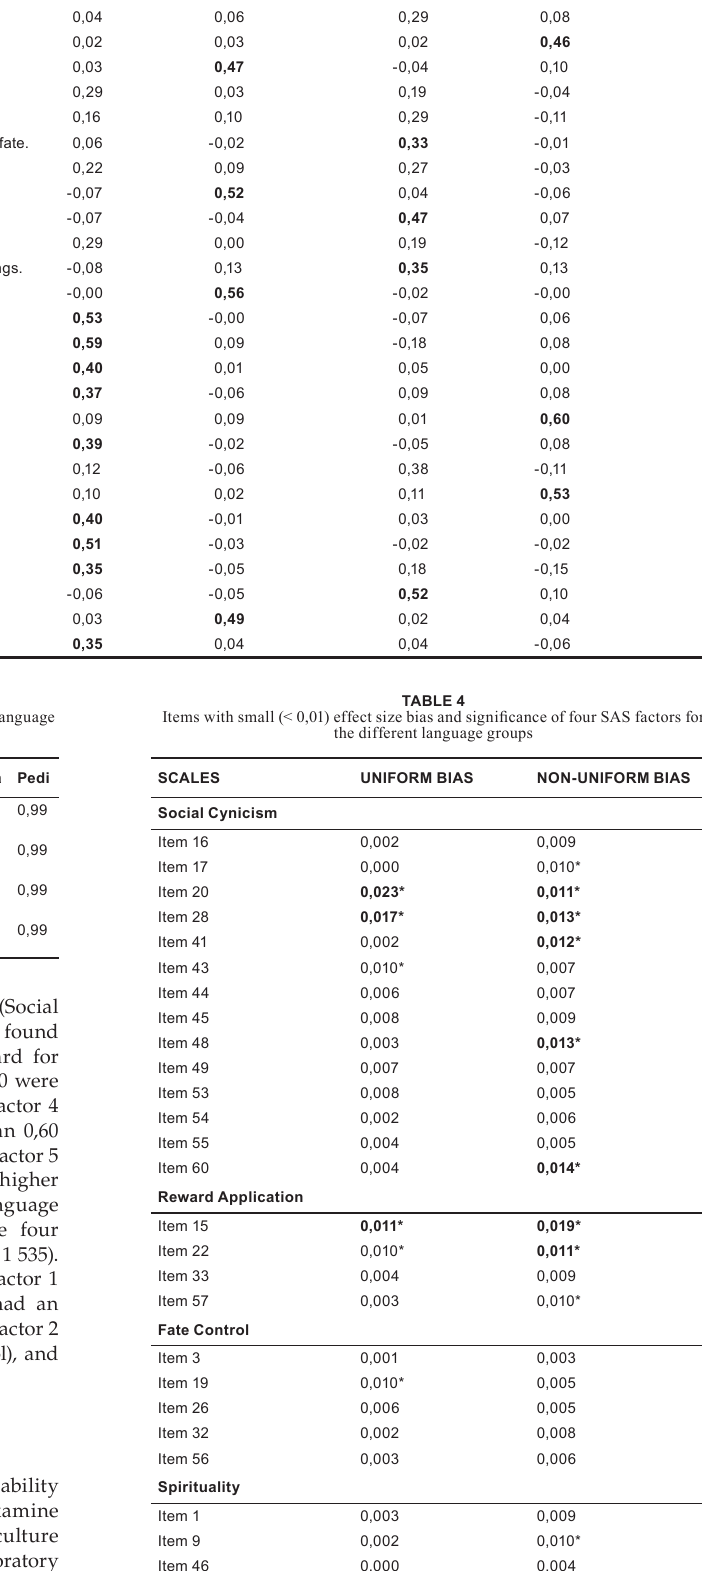
tABLe 2 Confirmatory factor analysis on the SAS items (loadings > 0,30) FActor 5: FActor 2: FActor 4: Social cynicism reward for Application Fate control Spirituality/ religiosity 0,46